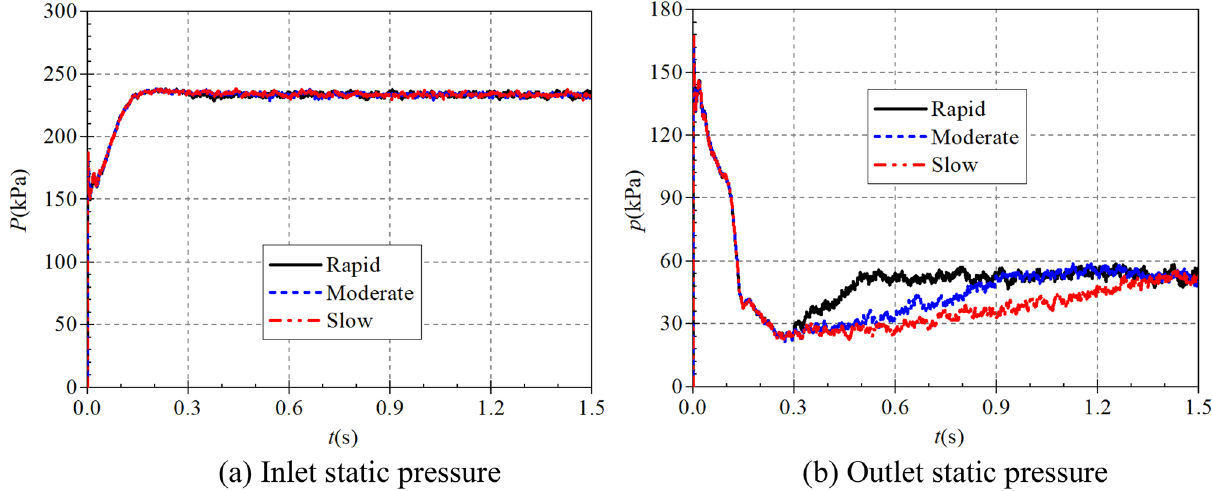
Figure 10. Instantaneous static pressure rise characteristics. ( a ) Inlet static pressure, ( b ) Outlet static